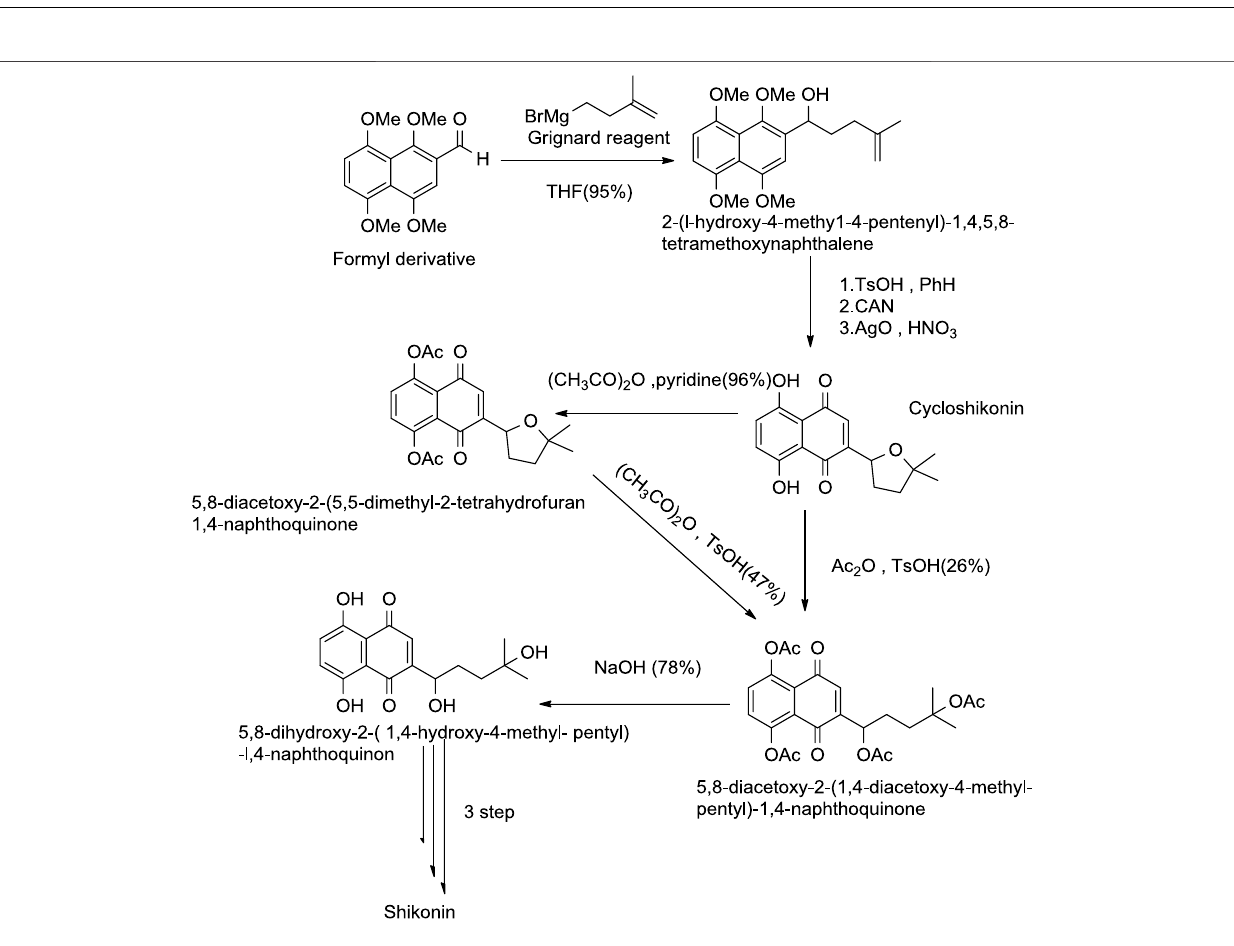
SCHEME 13 | Terada approach by cycloshikonin for the synthesis of shikonin (Tanoue et al., 1987).